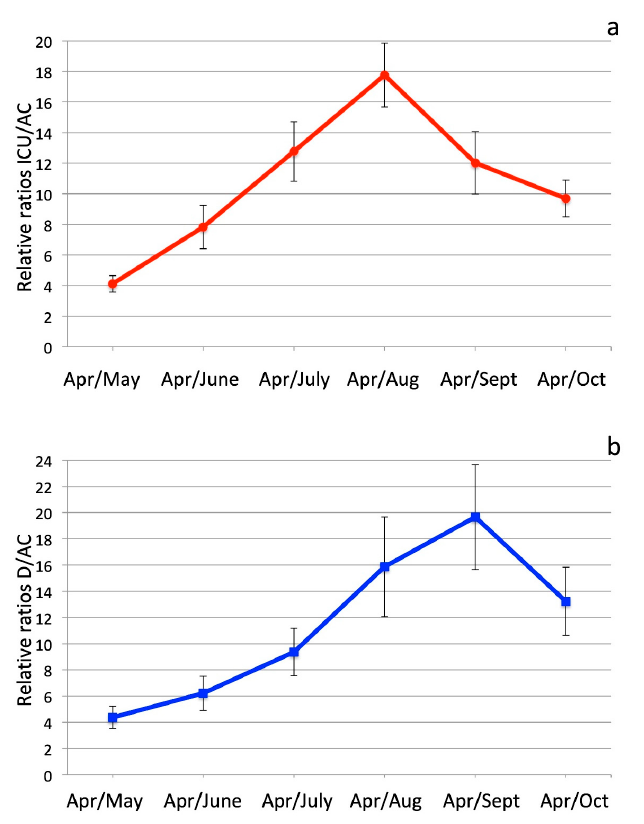
Figure 2. ( a ) Relative ratios of ICU / AC in April, with respect to the following months May to August. Error bars are as in Table 1 (statistical errors at 95% probability level, i.e., two standard deviations). ( b ) Relative ratios of D / AC in April, with respect to the following months May to August. Error bars are as in Table 1 (statistical errors at 95% probability level, i.e., two standard